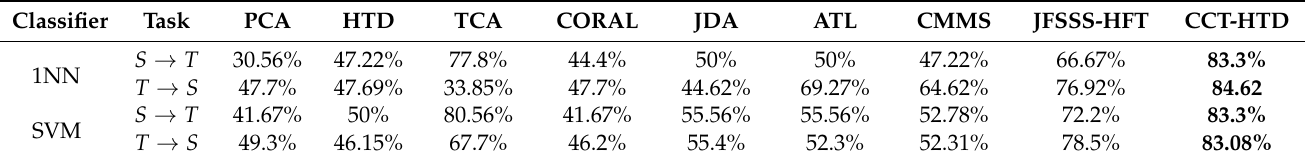
Figure 12. Examples of interferences samples. ( a , b ) Display the interference samples of other type of airplanes. ( c – e ) Show the interference samples of other type of tanks. Table 8. Classification accuracies of different domain adaptation methods by adding interference samples with 1NN and SVM using dataset